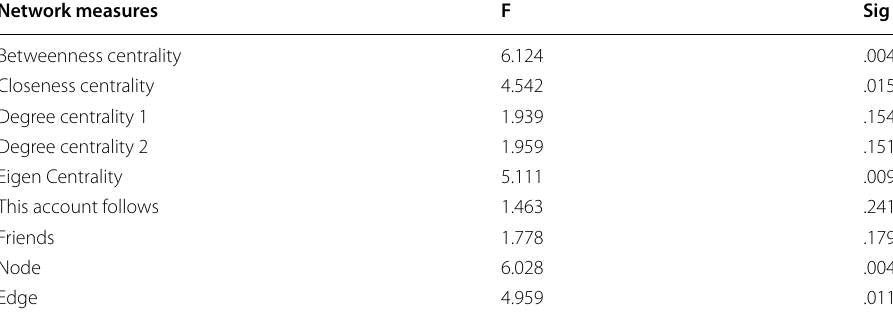
Table 9 The summary results of the post-hoc between-groups ANOVA test Network measures F Sig Betweenness centrality 6.124 .004 Closeness centrality 4.542 .015 Degree centrality 1 1.939 Degree centrality 2 1.959 Eigen Centrality